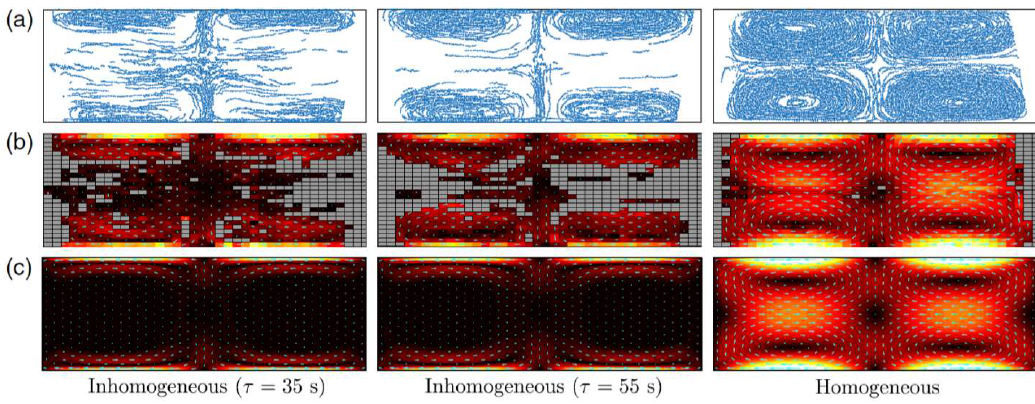
Figure 8. ( a ) Experimental particle positions ( b ), experimental streaming velocity, and ( c ) simulated streaming velocities for inhomogeneous and homogenous fluids. Reproduced with permission from [44].